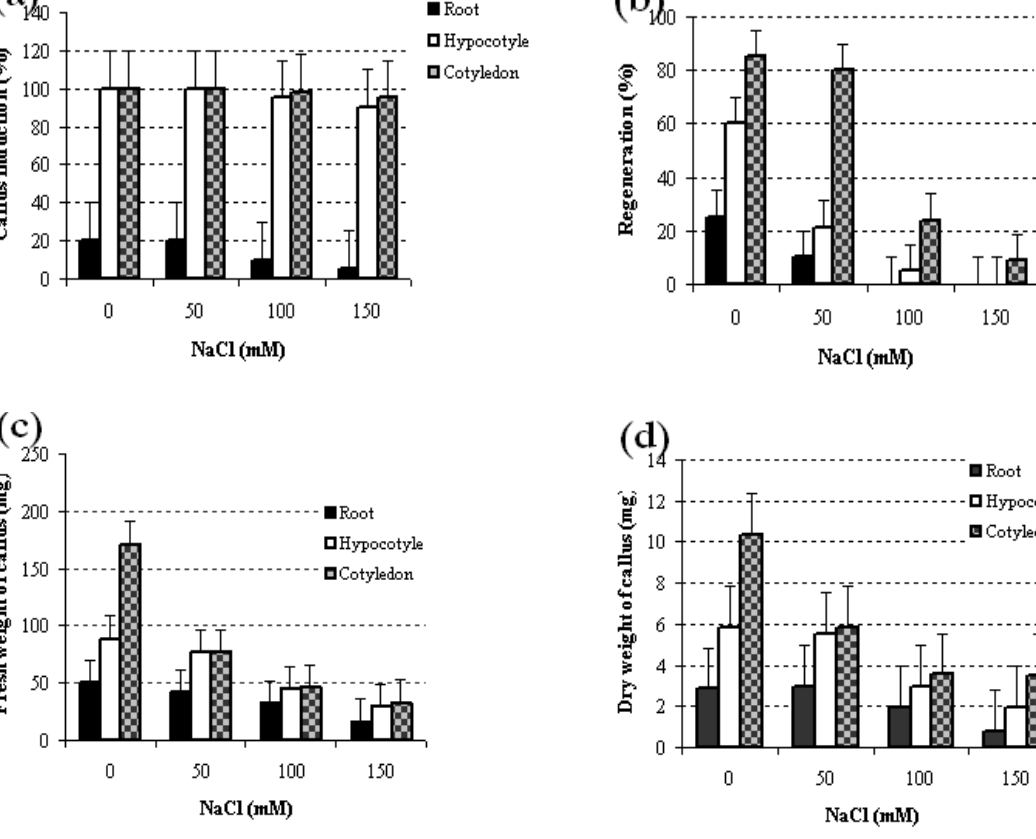
Fig. 3. Interaction effect salinity and explants on (a) callus induction, (b) shoot regeneration, (c) fresh weight and (d) dry weight of Foeniculum vulgare on MS medium containing 2 mg l -1 NAA and 0.5 mg l -1 kinetin (media